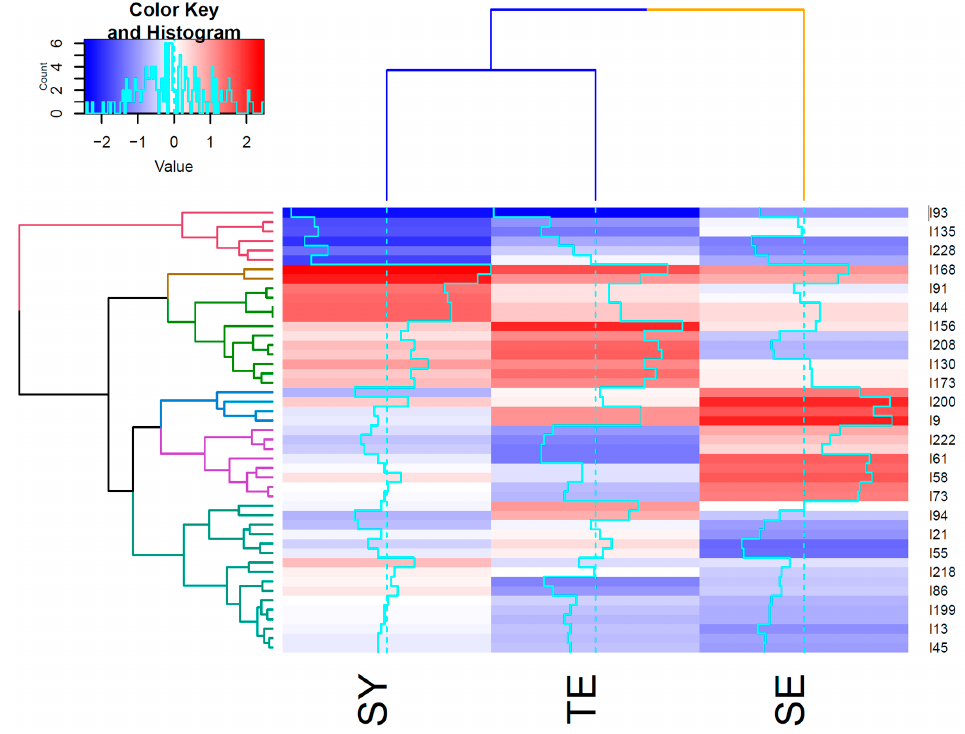
Figure 5. Distances among clusters and measurement items.